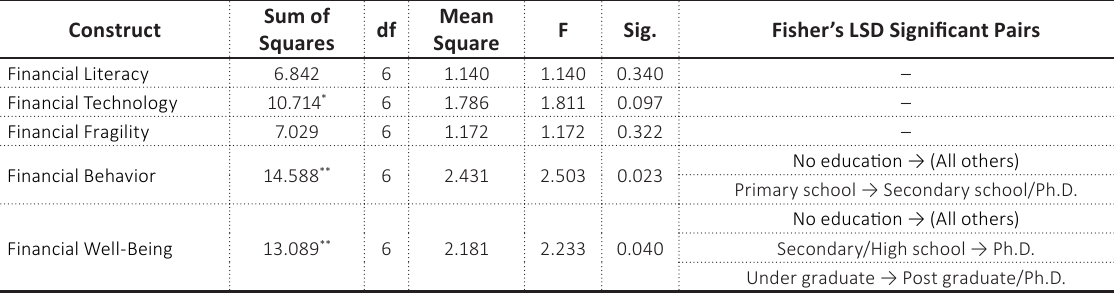
Table 14. One-way ANOVA for each factor across mother’s education Sum Construct